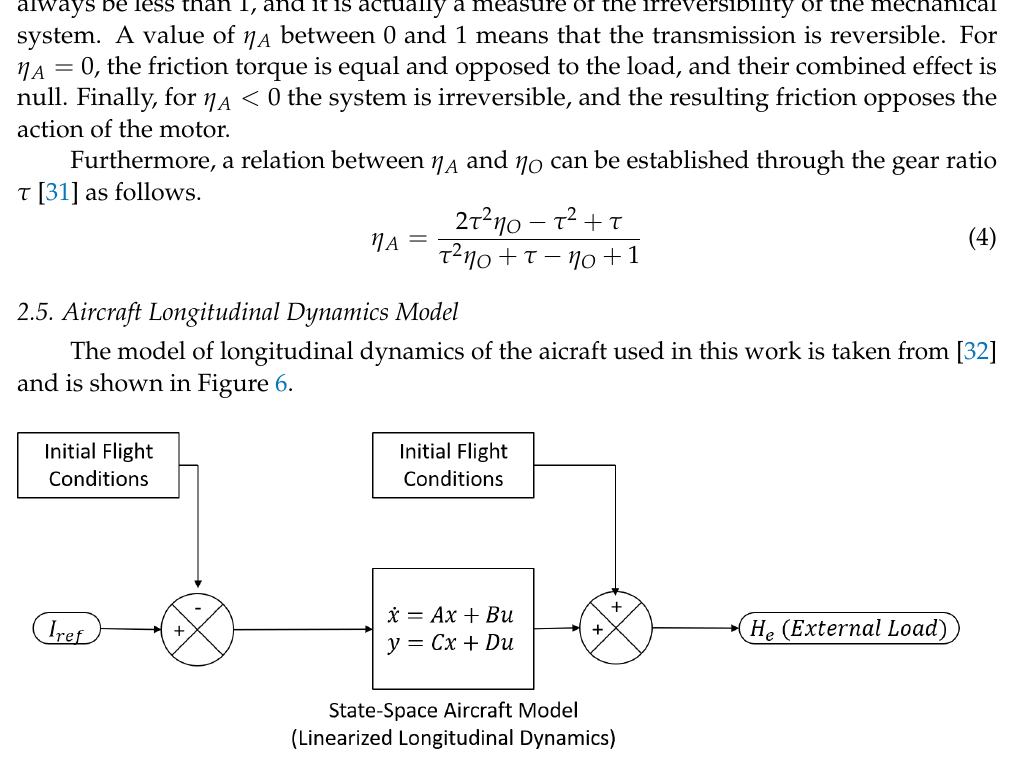
Figure 6. Aircraft Longitudinal Dynamics Model [32]. Airspeed, angle of attack, rate of pitch and other variables related to the dynamic behavior of the aircraft are also calculated but are not shown for the sake of